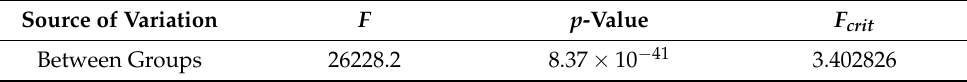
Table 2. An ANOVA analysis between the three observed variables. Source of